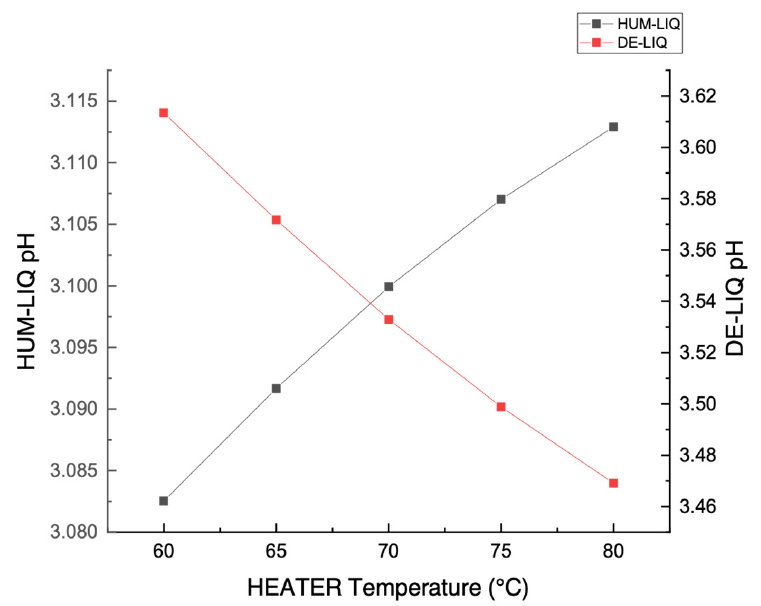
Figure 5. HUM-LIQ pH and DE-LIQ pH as a function of HEATER temperature.